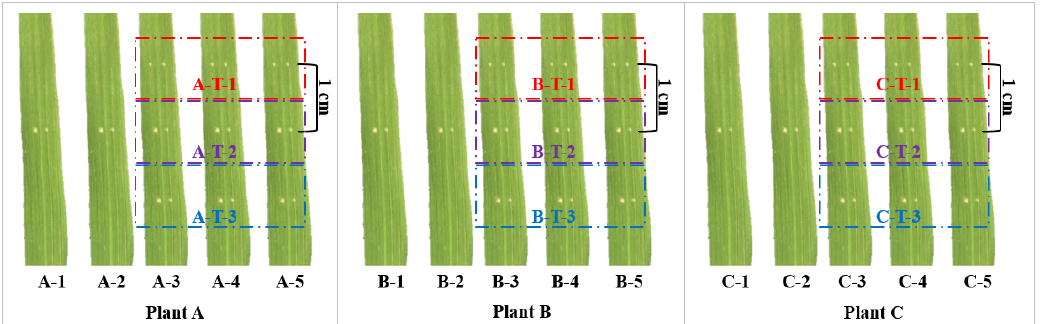
Figure 7. Schematic diagram of rice inoculation and sampling. Three rice plants A, B and C were inoculated with 5 leaves each, leaves 1, 2 were inoculated once for the measurement of diseased spots; leaves 3–5 were used for transcriptome sequencing, and each leaf was inoculated 3 times, and the inoculation interval was 1 cm. The T-1 region of the leaves of three rice plants was collected as biological repeat 1 and the T-2 region and T-3 region as biological repeat 2 and 3, respectively.